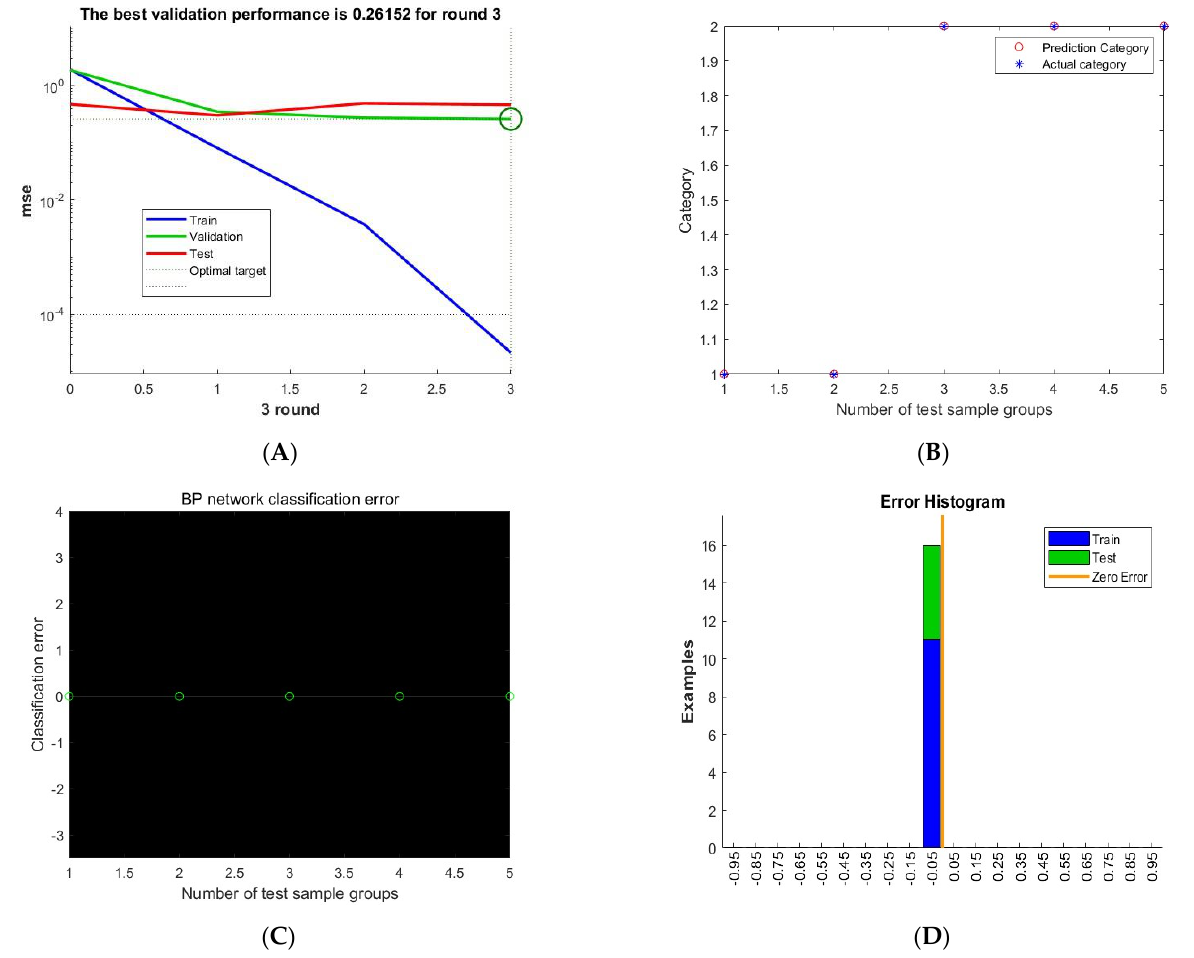
Figure 11. ( A ) Performance graph of the neural network; ( B ) classification images of predicted and actual species of the model; ( C ) classification error graph of the test set; ( D ) histogram of the error distribution.